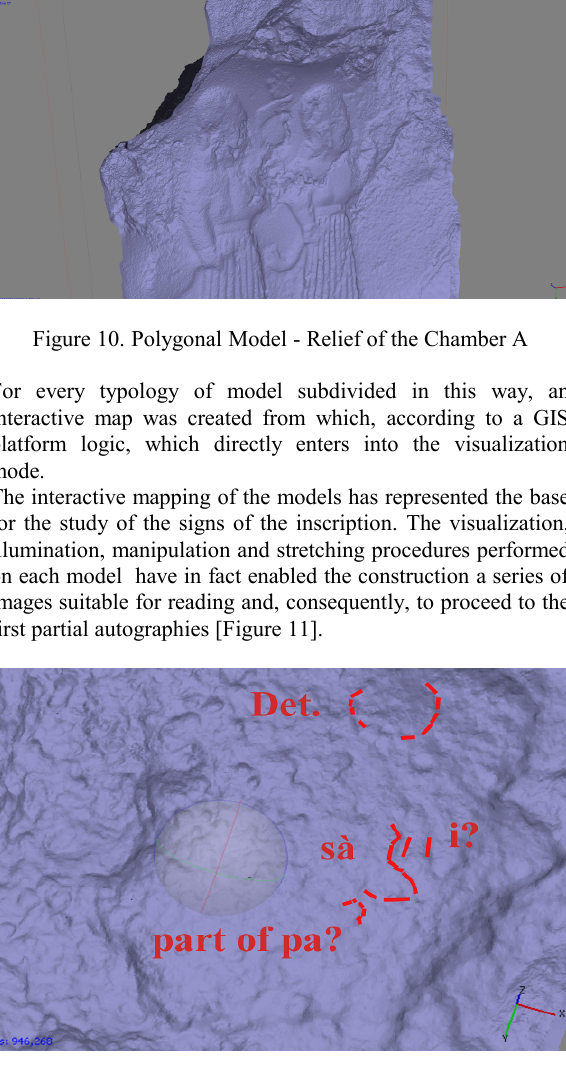
Figure 11. Possible identification of the traces by the model This work, which is still in progress, consists of a model-by- model mapping into an interactive general